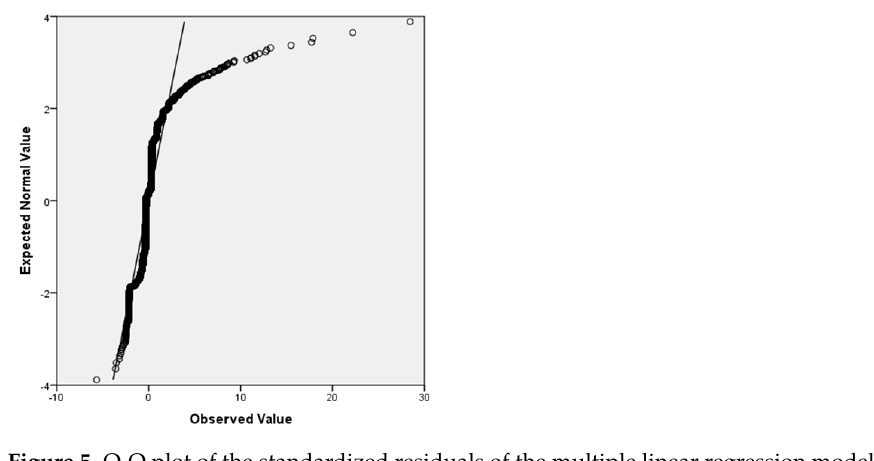
Figure 5. Q-Q plot of the standardized residuals of the multiple linear regression model. Table 2. Tolerance and Variance Inflation Factor for the multiple linear regression model.